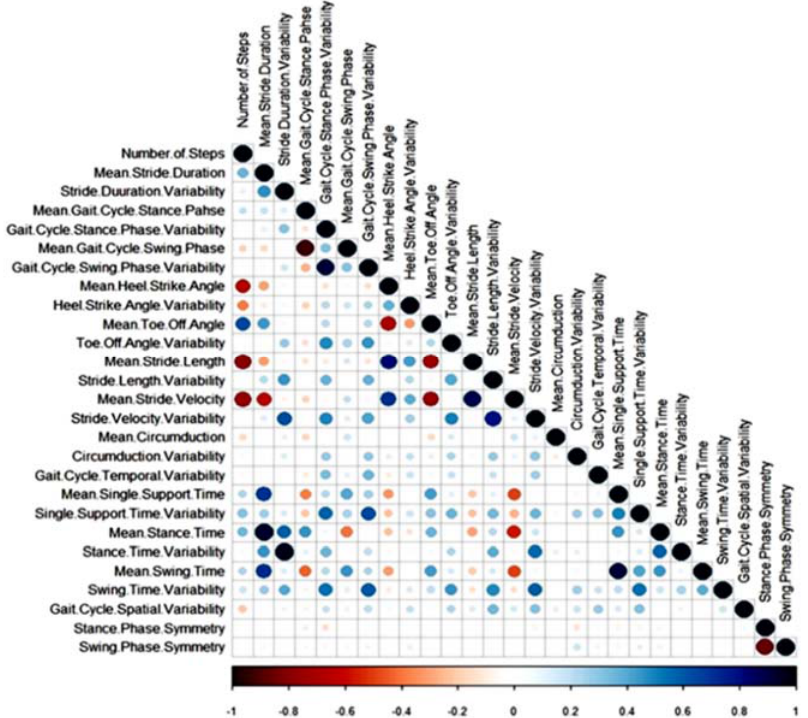
Figure 2. Radar plot indicating the difference between fallers and non ‐ fallers in a range of gait characteristics using z ‐ scores (* indicates significant difference between groups ( p ‐ value < 0.05)).